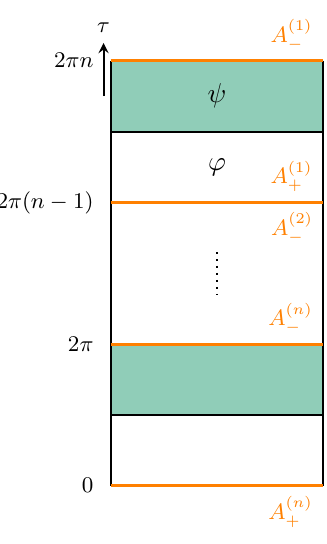
Figure 16 . The replica partition function Z ( n ) for the pseudo entropy.